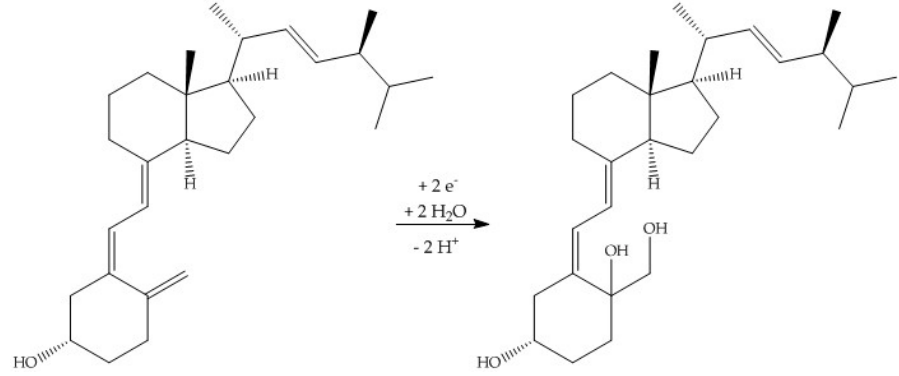
Figure 5. Proposed hydroxylation of ergocalciferol, leading to a 10,19-hydroxylated ergocalciferol